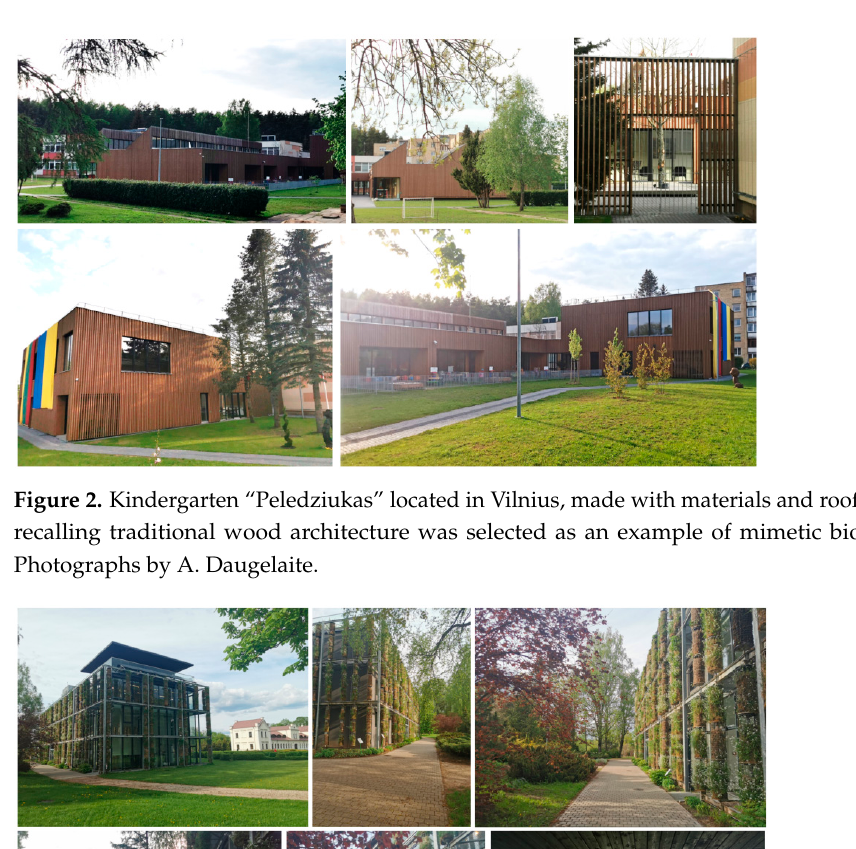
Buildings 2022 , 12 , x FOR PEER REVIEW 8 of 16